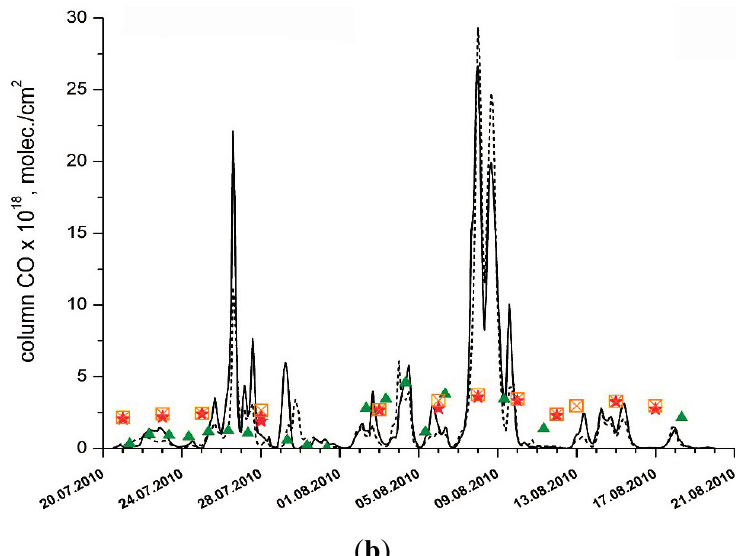
Figure 9. Experimental for OIAP ( a ) and ZSS ( b ) stations and model (RAMS/HYPACT) CO total columns. The model CO total column has been obtained for the hot spots, predicted by MODIS/Terra satellite (solid line) and MODIS/Aqua satellite (dashed line). The triangles in the plot indicate the exceeding of experimental values over